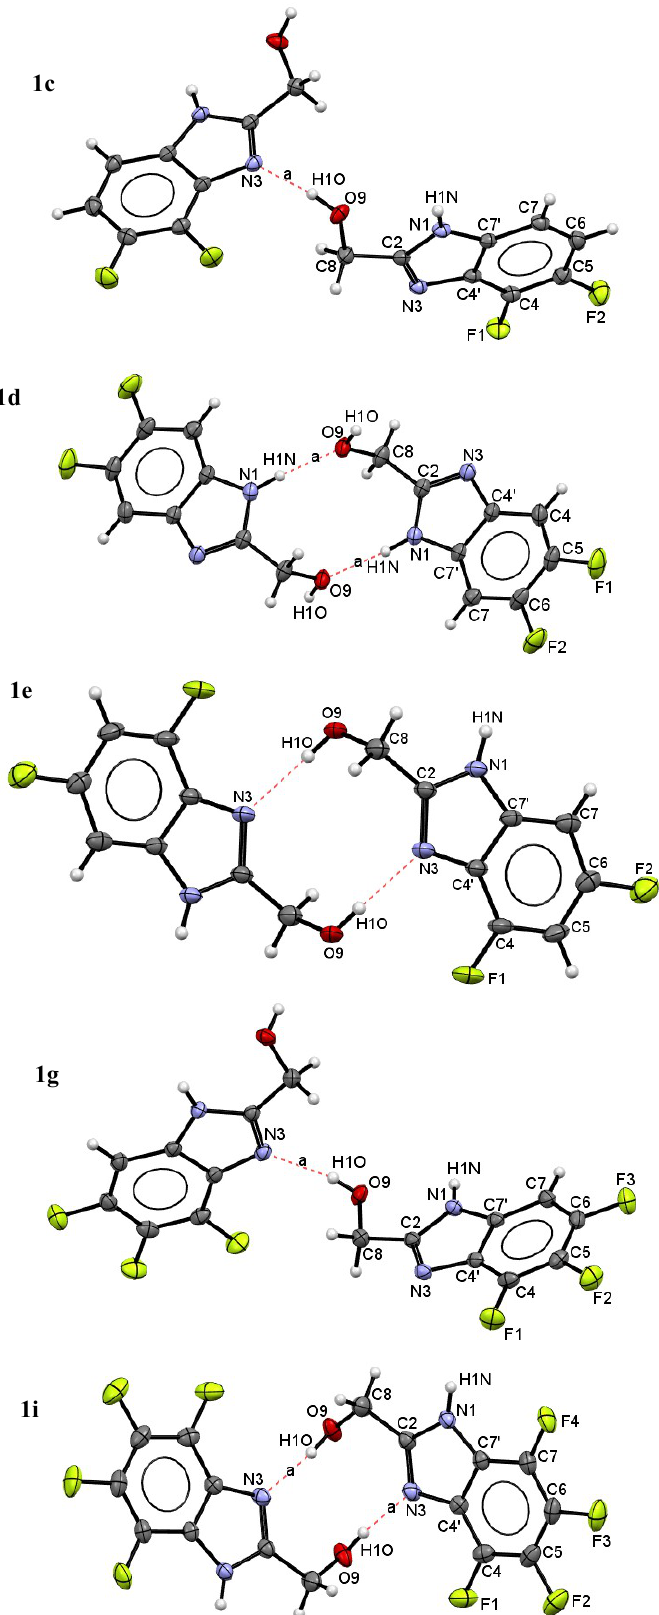
Figure 2. Fragments of crystal structure showing H‐bonded dimers of benzimidazoles 1b – e , 1g , and 1i . H‐bonds N1–H…O9 and O9–H…N3 are indicated by red dashed lines.